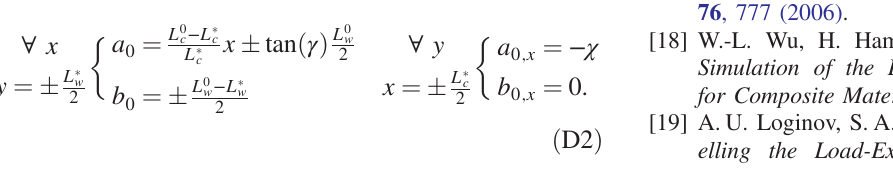
FIG. 10. Amplitude of the vector Lagrange multiplier k evaluated for ε ¼ 11% and displayed over the corresponding picture of the fabric, where the color of each stich is set by the ⃗ T numerical value of k tot k